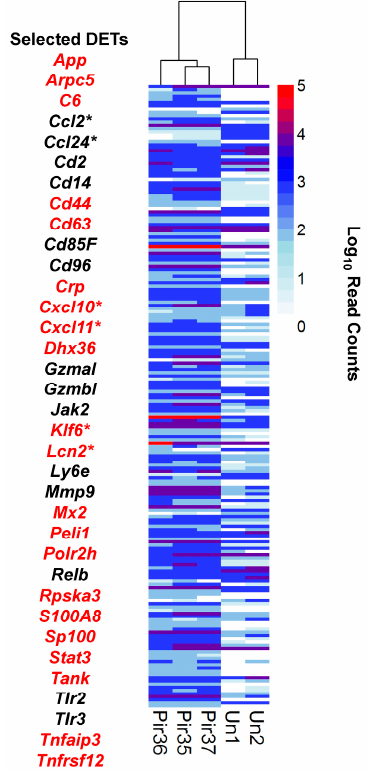
Figure 5. General innate immune response and cytokine signaling. Differential expression (DESeq) data was plotted by cluster analysis with R software (pheatmap). Infected (Pir35, Pir36, Pir37) and uninfected (Un1, Un2) hamster livers. Histogram shows read count densities (log10) for 195 transcript isoforms or alleles from 153 unique genes. Selected transcripts from this set are listed to the left of the histogram; starred transcripts are expected to occur during the pro-inflammatory macrophage M1 response; transcripts in red font are enriched in the liver infected vs. uninfected dataset of Djavani et al. [16].